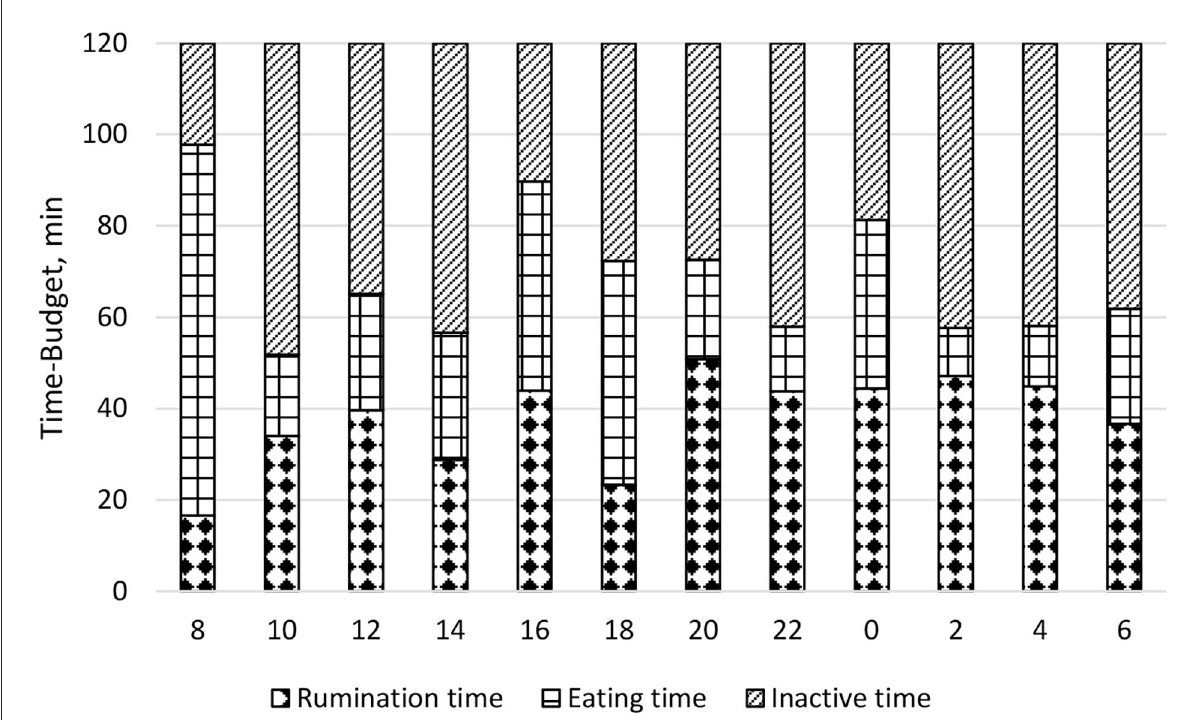
FIGURE6 Daily cows’ time-budget (min) on 2h bases during the fecal sampling period. Rumination time: time spent ruminating; Eating time: time spent eating; Inactive time: time spent without ruminating or eating. Time-budget display was made according to Raspa et al. (35).